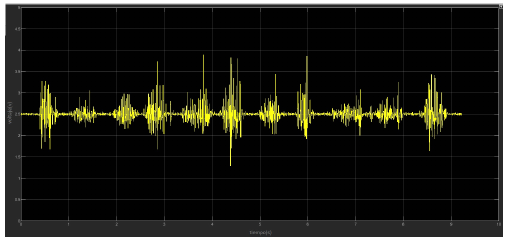
Figure 12. EMG signal acquired by the developed sensor and displayed in the virtual oscilloscope designed in Simulink. The signal is traced in real